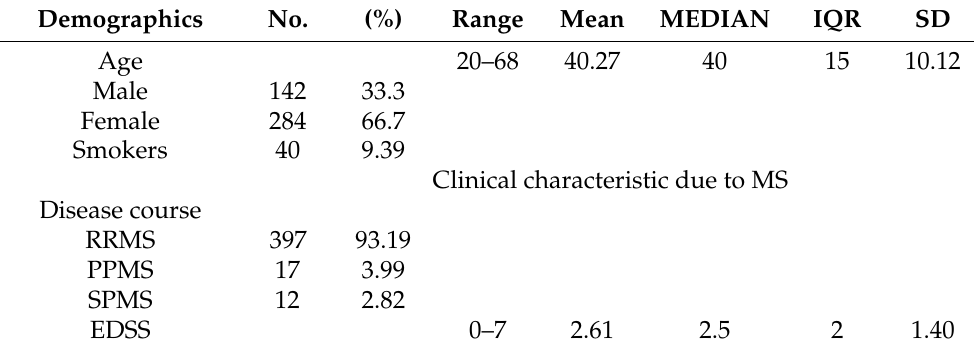
Table 1. Demographics and clinical characteristic of patients with